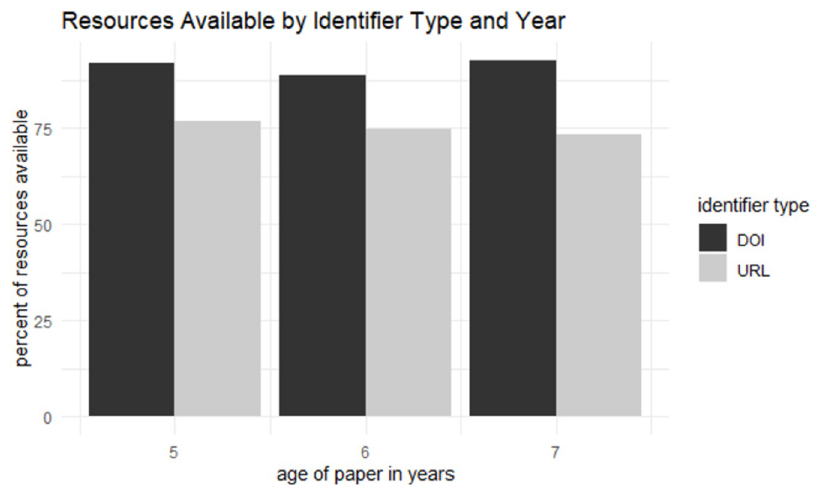
Fig 2. Resource availability by year and identifier